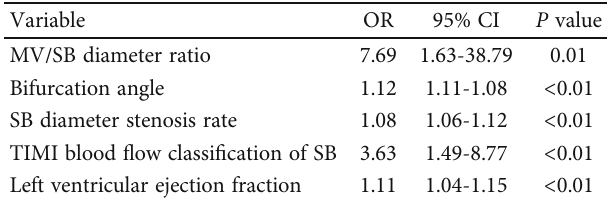
Figure 1: ROC curve.